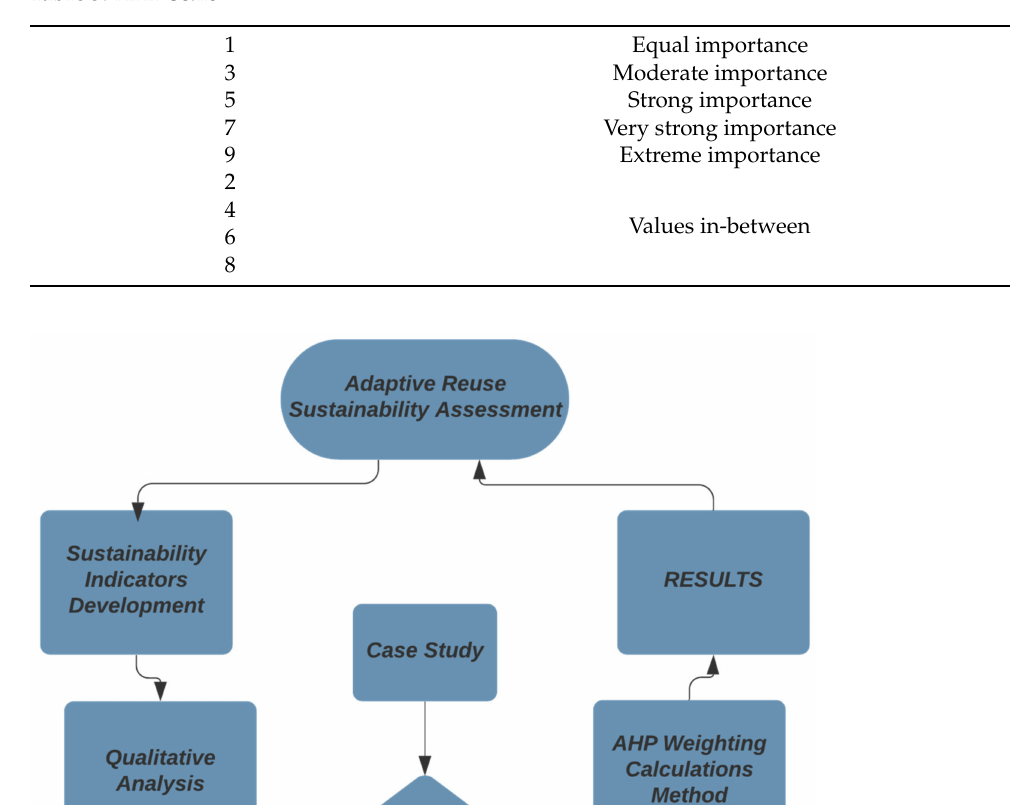
Table 3. AHP scale.